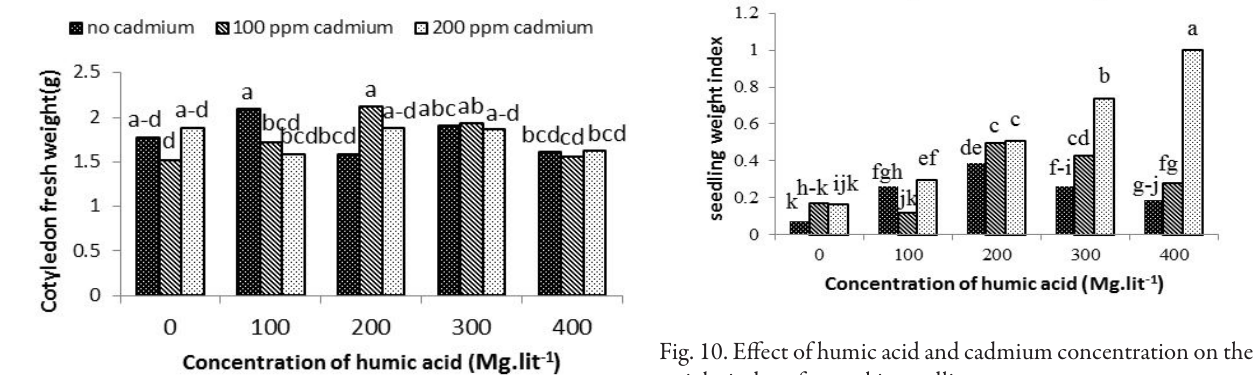
Fig. 10. Effect of humic acid and cadmium concentration on the